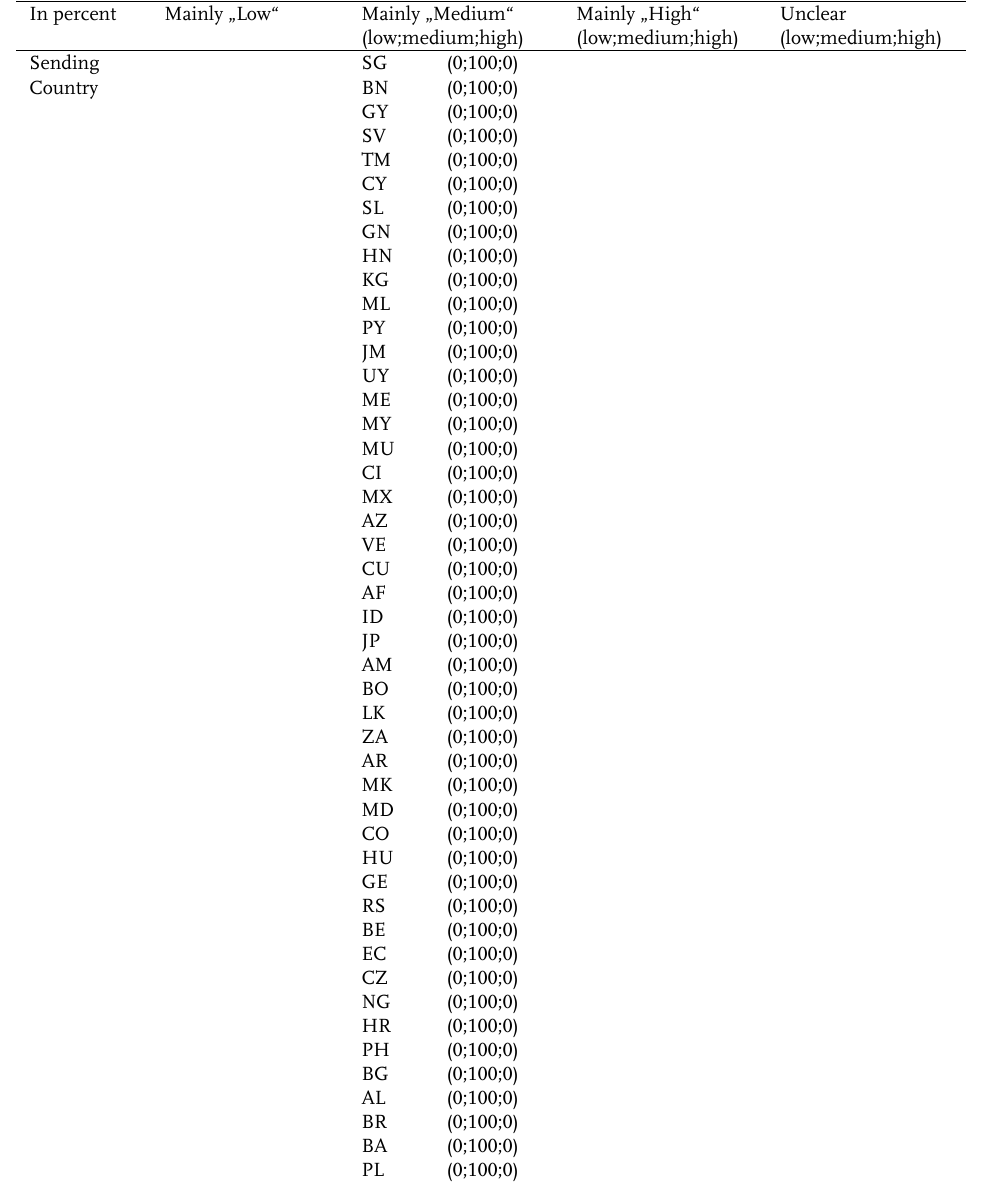
Table A.7 : Average belonging to sending and receiving contexts based on cases for female